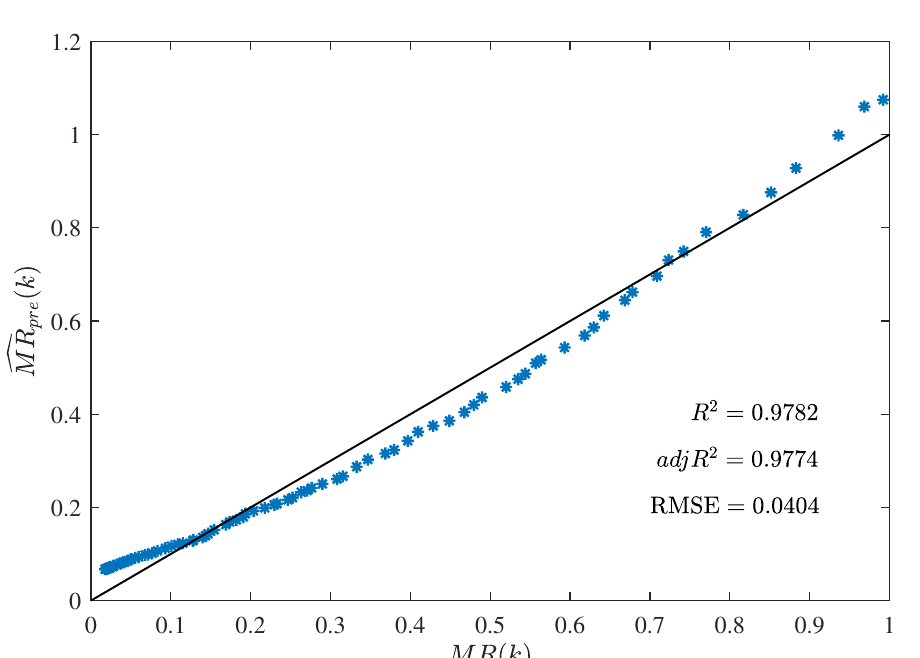
Figure 9. The comparison between the predicted moisture ratio (cid:100) MR pre ( k ) and the experimental moisture ratio MR ( k )